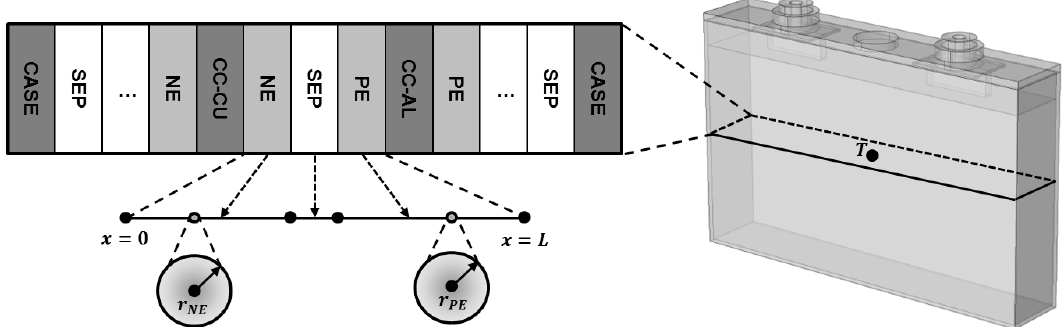
Figure 1. Schematics of the lithium-ion battery and heat transfer model.